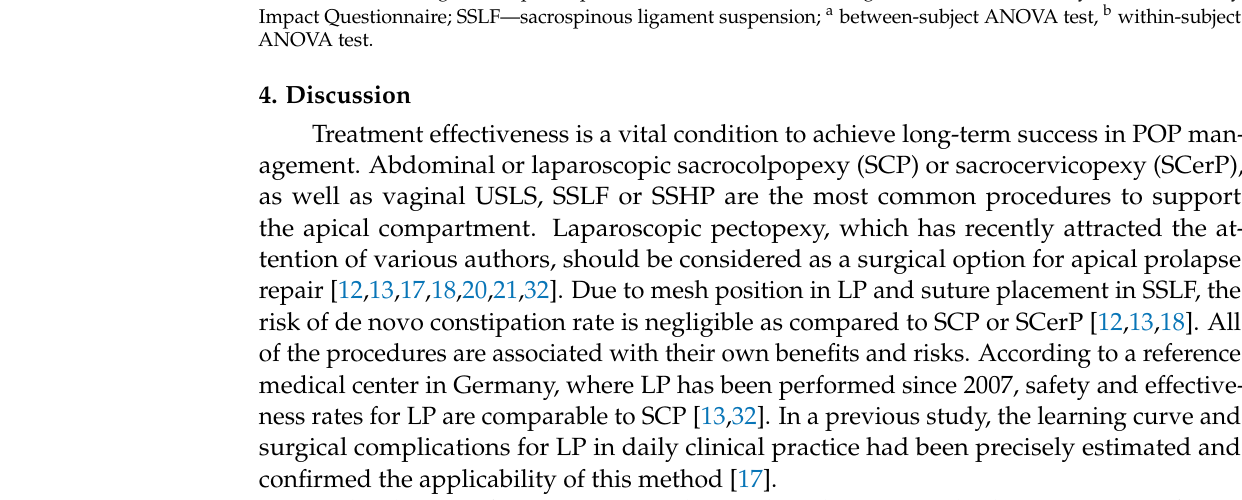
Comparison of Change between